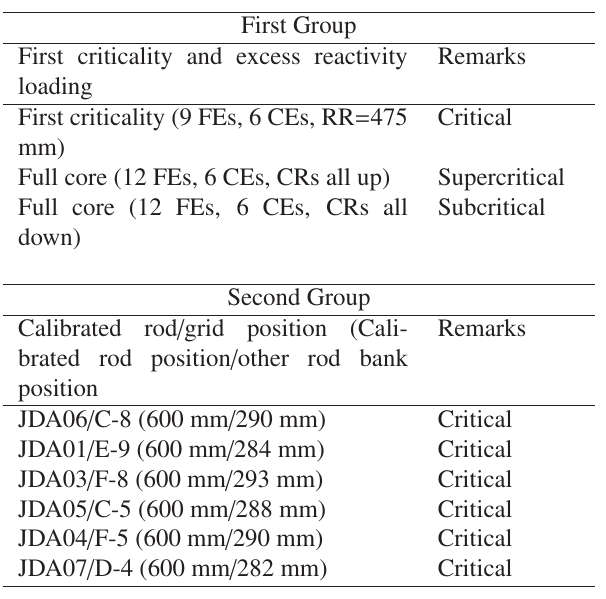
Table 3. E ff ective total delayed neutron fractions for di ff erent